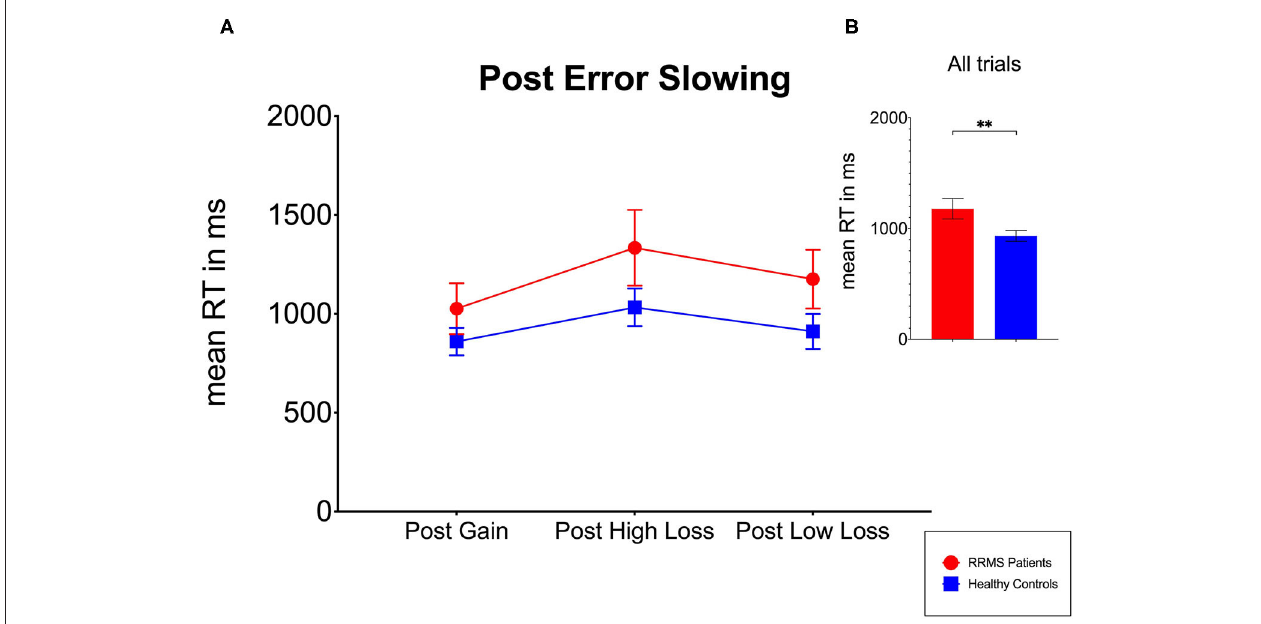
FIGURE 2 | Evaluation of post-error slowing (PES) for RRMS patients and HCs. (A) RRMS patients and HCs exhibit a similar pattern of PES as no significant interaction between the factors group and trial type emerged. (B) The overall reaction times in the RRMS patients were significantly higher compared to the HCs. RT , reaction times; RRMS , relapsing–remitting multiple sclerosis; HC , healthy controls. Values are presented as the means. Error bars indicate 95% confidence intervals. ** p < 0.01.